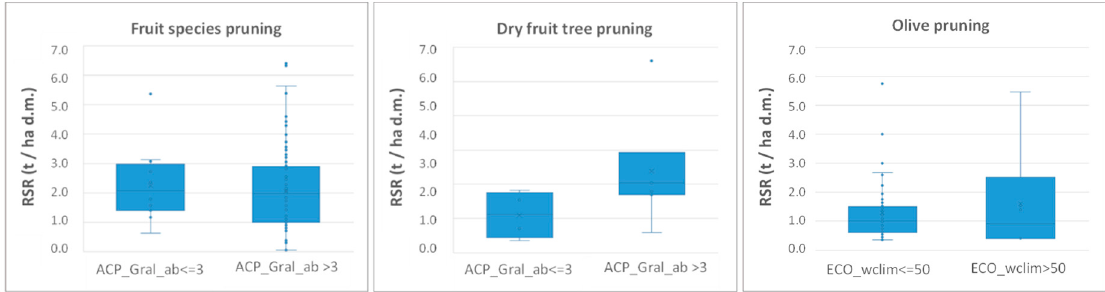
Figure 4. Whisker plots obtained by zoning the scatter plots of three crop groups.